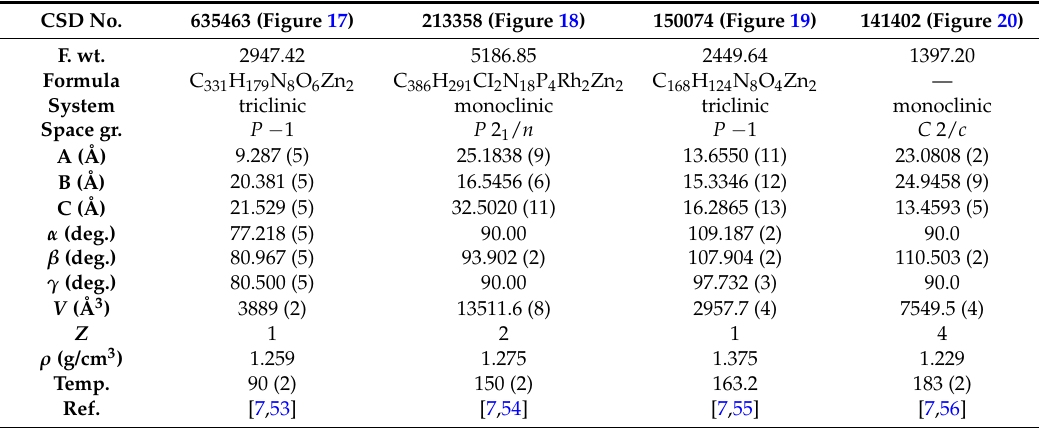
Table 5. Crystallographic Properties of Selected